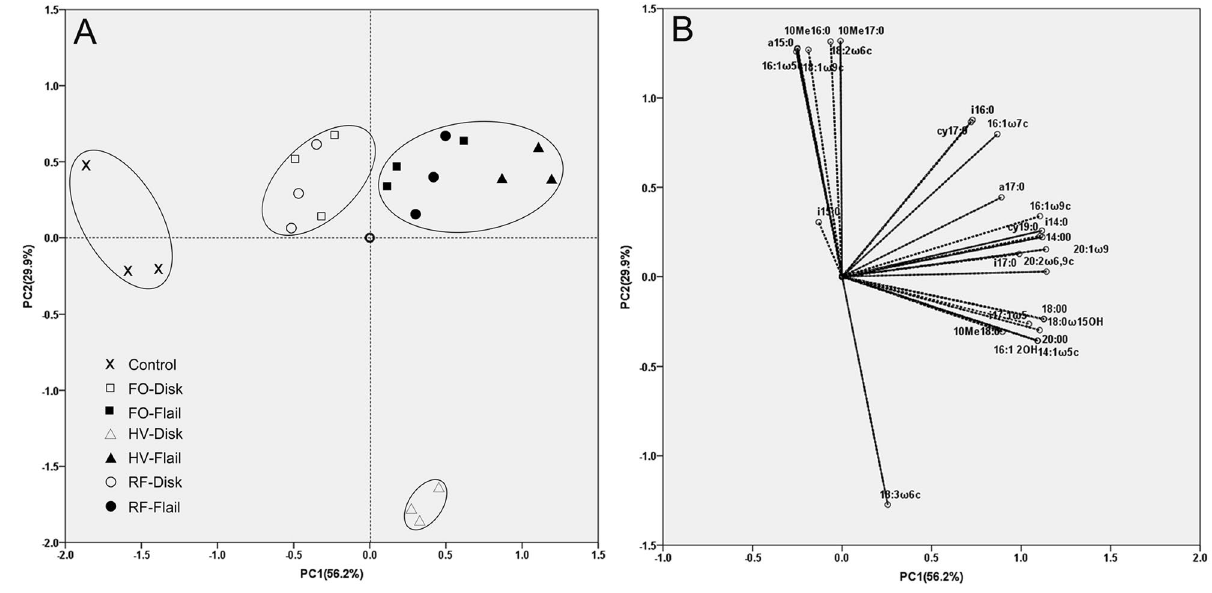
Figure 3. Principal components analysis (PCA) of fatty acid methyl esters (FAMEs) ( A ) and graph of variables ( B ) for individual FAMEs from a PCA of the green-manure and termination-method treatments. The 2D plot was generated by Canoco 4.5 (MicrocomputerPower, Ithaca, USA).